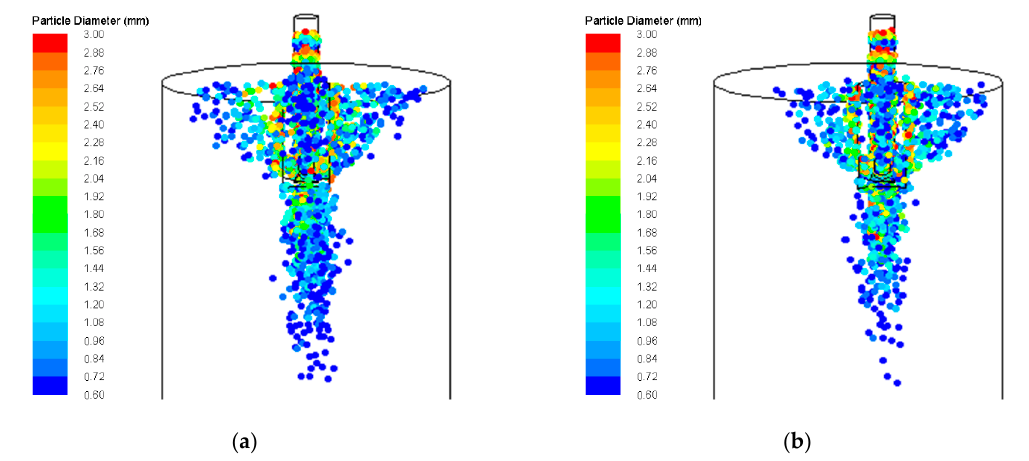
Figure 7. Distribution of argon bubbles of different SEN eccentric distances. ( a ) SEN eccentric distances is 0 mm; ( b ) SEN eccentric distances is 50 mm.